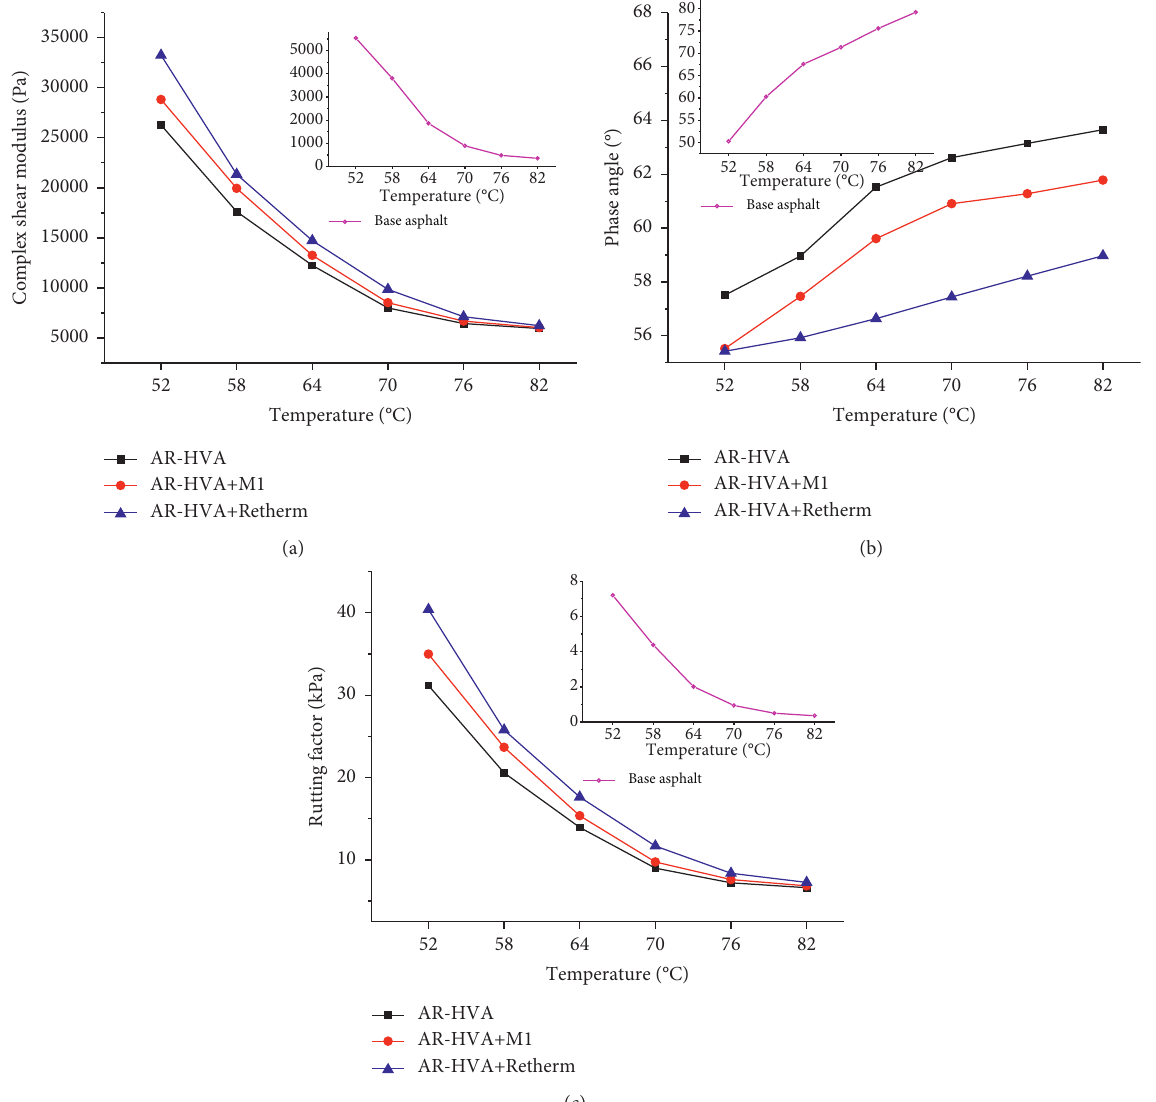
Figure 6: High-temperature rheological performance test results of asphalt. (a) Complex modulus ( G ∗ ) variation with temperature. (b) Phase angle variation with temperature. (c) Rutting factor variation with temperature.